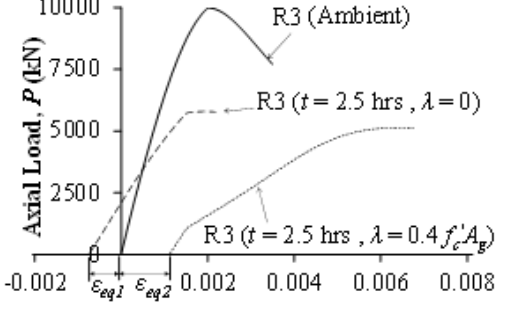
Figure 9. Development of various strain components along the discretized cross-section. Once equilibrium is achieved, ε σ i is applied as initial strains in the concrete and steel layers, whereas ε eq results in shifting the P - ε curve, as illustrated in Figure 10 for both rectangular and circular sections. The residual and equivalent strain distribution along column R3 and C3 cross-sections are shown in Figure 11. If the column is not initially loaded during fire exposure ( λ = 0), then the residual equivalent strain ( ε eq1 ) is always negative, causing the P - ε curve to shift to the expansion side. However, by imposing an initial load to the column during the heating phase, a transient strain component develops and counteracts the influence of the thermal strain. If the applied load is large enough, the column experiences residual contraction instead of expansion after the cooling, as indicated by the positive equivalent strain ( ε eq2 ). The change in stiffness is attributed to the elimination of the residual stress-induced strains. Restraining the column affects the magnitude of the generated transient strain, especially if the column is not subjected to initial load. When the column is restrained, part of the equivalent strain ( ε eq ) induces stresses within the section depending on the considered degree of restraint while maintaining the equilibrium condition. By restraining the column, additional compressive forces are developed in the column as a result of preventing the column’s tendency to expand.